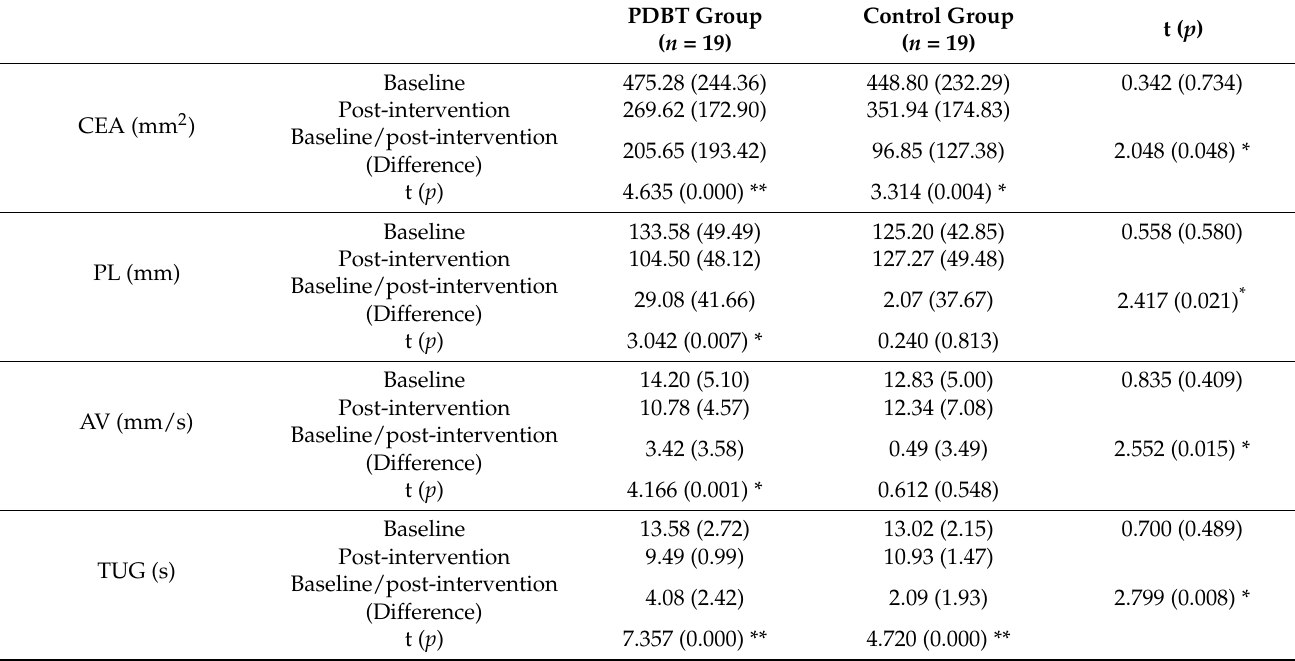
Table 3. Comparison of the ability to balance within and between the groups ( n =